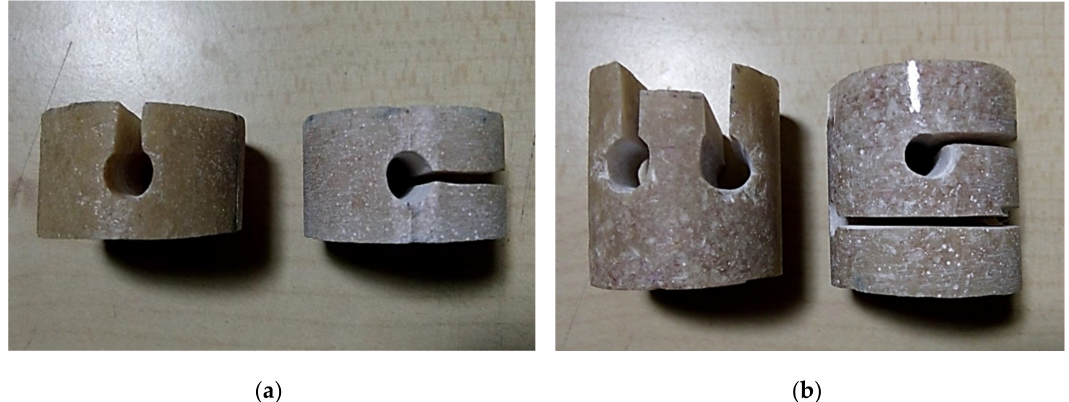
Figure 5. ( a ) The 15 mm Placuna placenta SFRP with Front-Tailed cavity treatment (left) and Side-Tailed cavity treatment (right); ( b ) The 30 mm Placuna placenta SFRP with Front-Tailed cavity treatment (left) and Side-Tailed cavity treatment